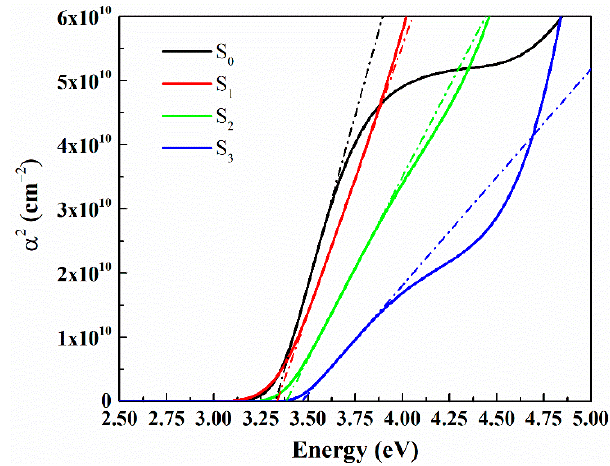
Figure 7. The α 2 vs. energy for Be implanted GaN samples at RT.